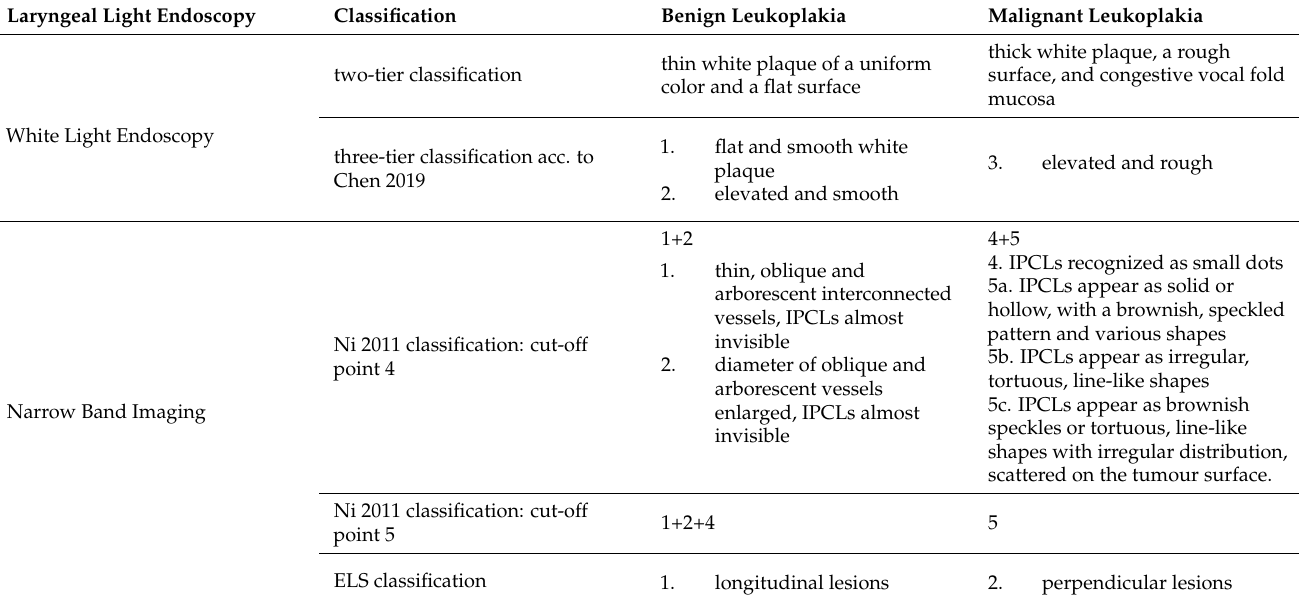
Table 1. Description of the classifications used with determined cut-off points (IPCLs—intraepithelial papillary capillary loops; VF—vocal fold; ELS—European Laryngological Society) [7,22–24]. Laryngeal Light Endoscopy Classification Benign Leukoplakia Malignant Leukoplakia two-tier classification White Light Endoscopy